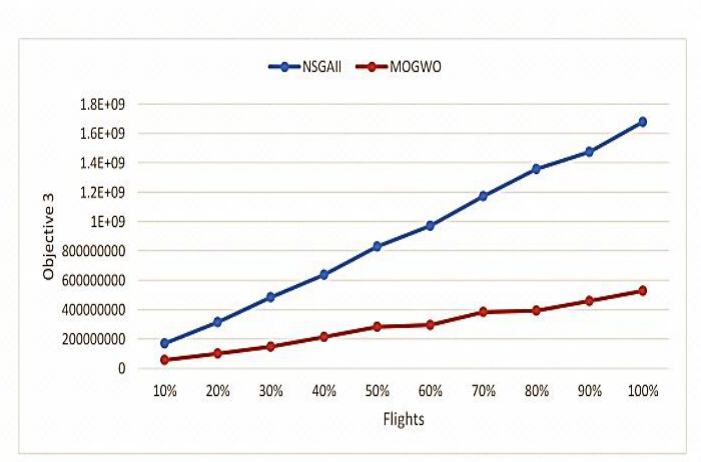
Fig. 4. Comparison of MOGWO and NSGAII methods based on the third -objective